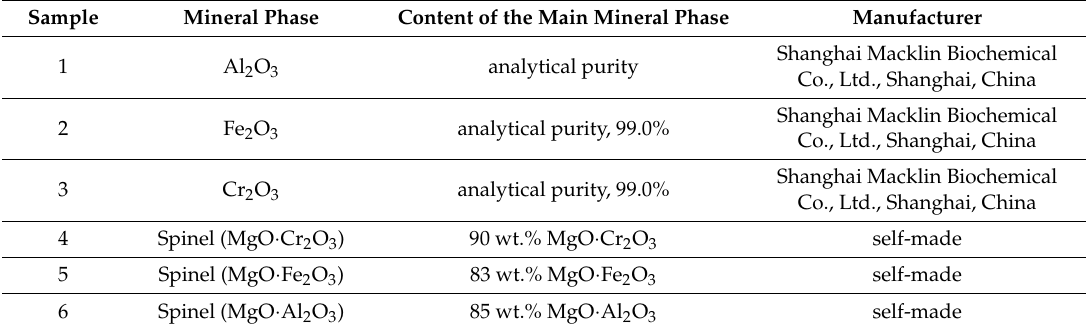
Table 1. Composition and mineral phase of the refractory samples determined by XRD analysis.